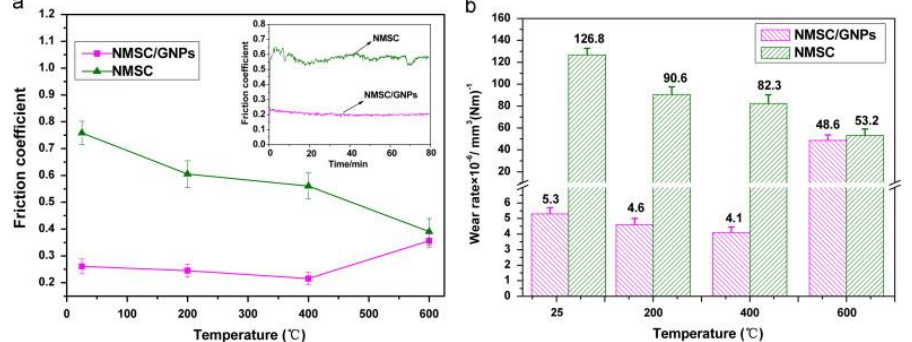
Figure 16. Variation in CoF of ( a ) NMSC and NMSC − GNP and wear rates of ( b ) NMSC and NMSC − GNP. Reproduced with permission from [125]. Copyright Elsevier, 2014.